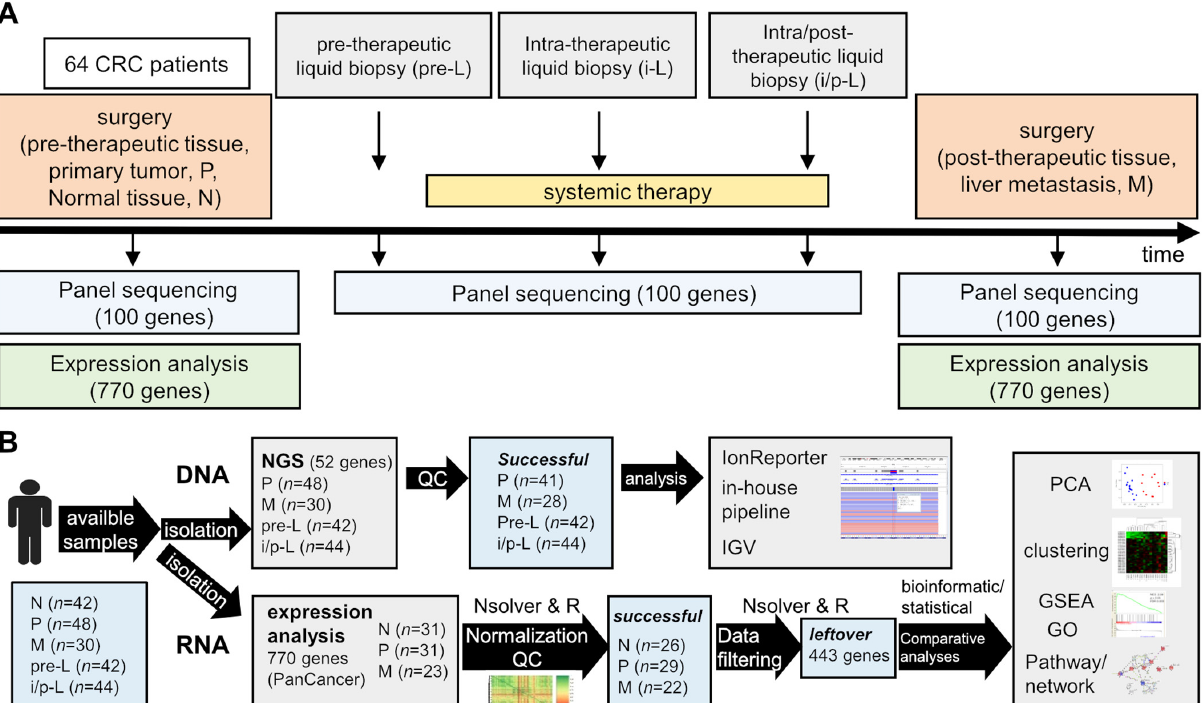
Figure 1. Design ( A ) and workflow of the data analyses ( B ) of the REVEAL study (M, post-therapeutic tissue, liver metastasis; N, normal tissue in the vicinity of the primary tumor; P, pre-therapeutic primary tumor; i-L, intra-therapeutic liquid biopsy; i/p-L, intra/post-therapeutic liquid biopsy); GO, gene ontology analysis; GSEA, gene set enrichment analysis; IGV, integrative genomics viewer; PCA, principal component analysis; QC, quality control. Table 1. Patient and tumor baseline characteristics.